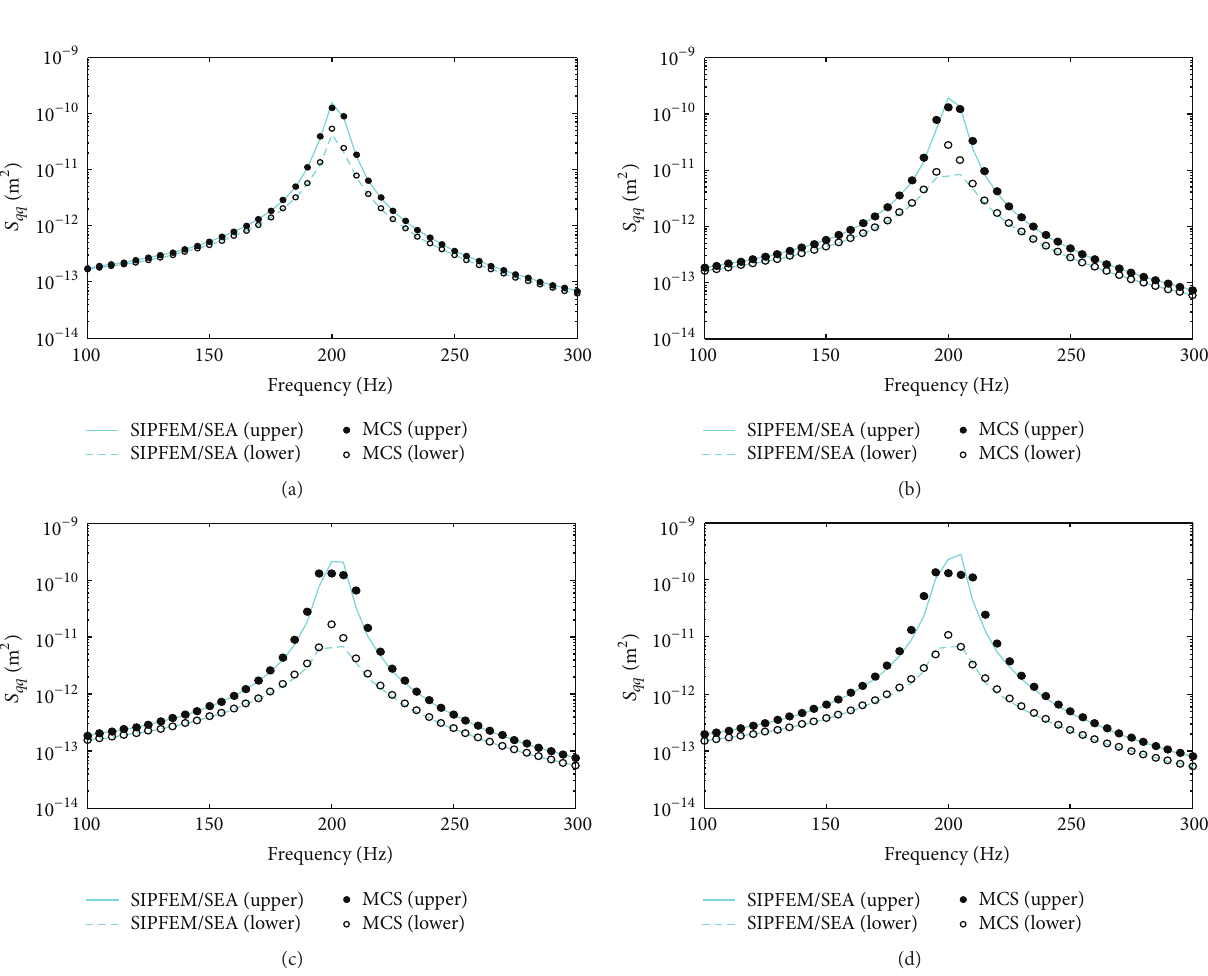
Figure 3: The bounds of the autospectra of the mass displacements: (a) 𝛼 = 0.01 ; (b) 𝛼 = 0.02 ; (c) 𝛼 = 0.03 ; (d) 𝛼 = 0.04 .